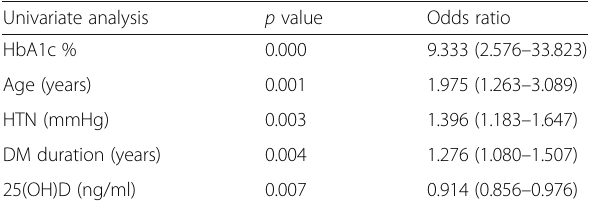
Table 4 Regression analysis of risk factors for DPN in patients with type 2